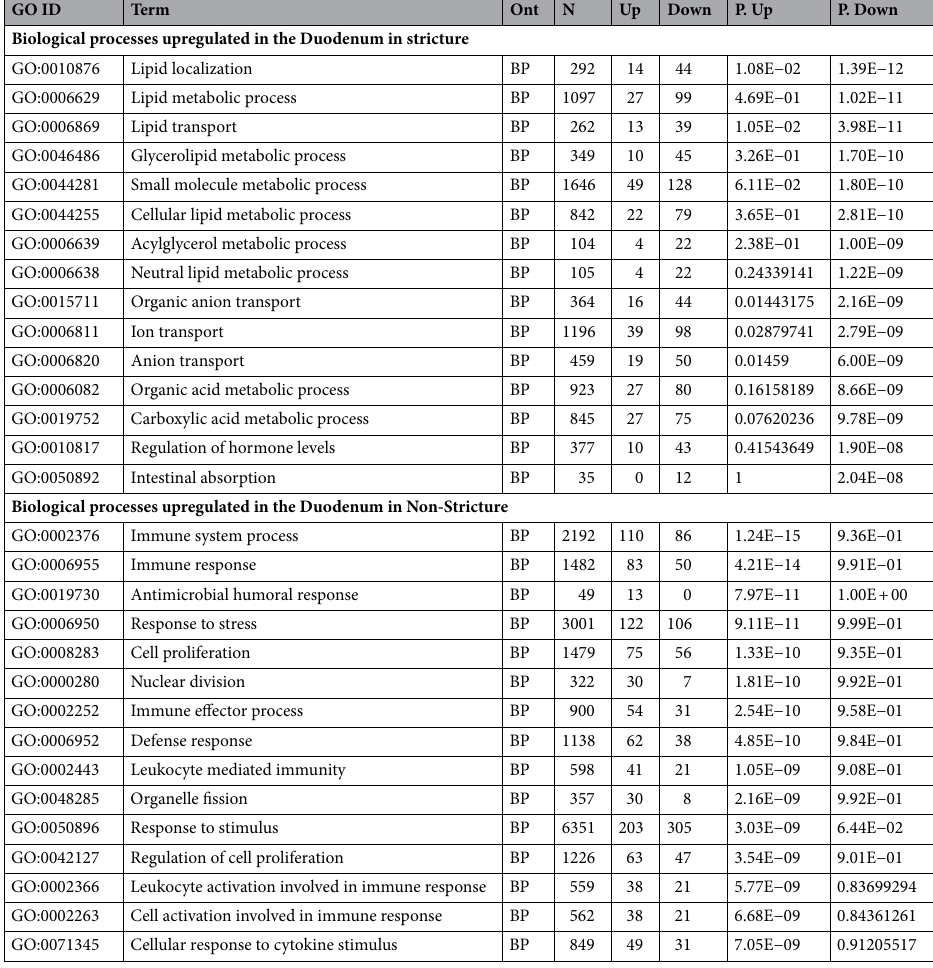
Table 2. Top gene ontology sets in